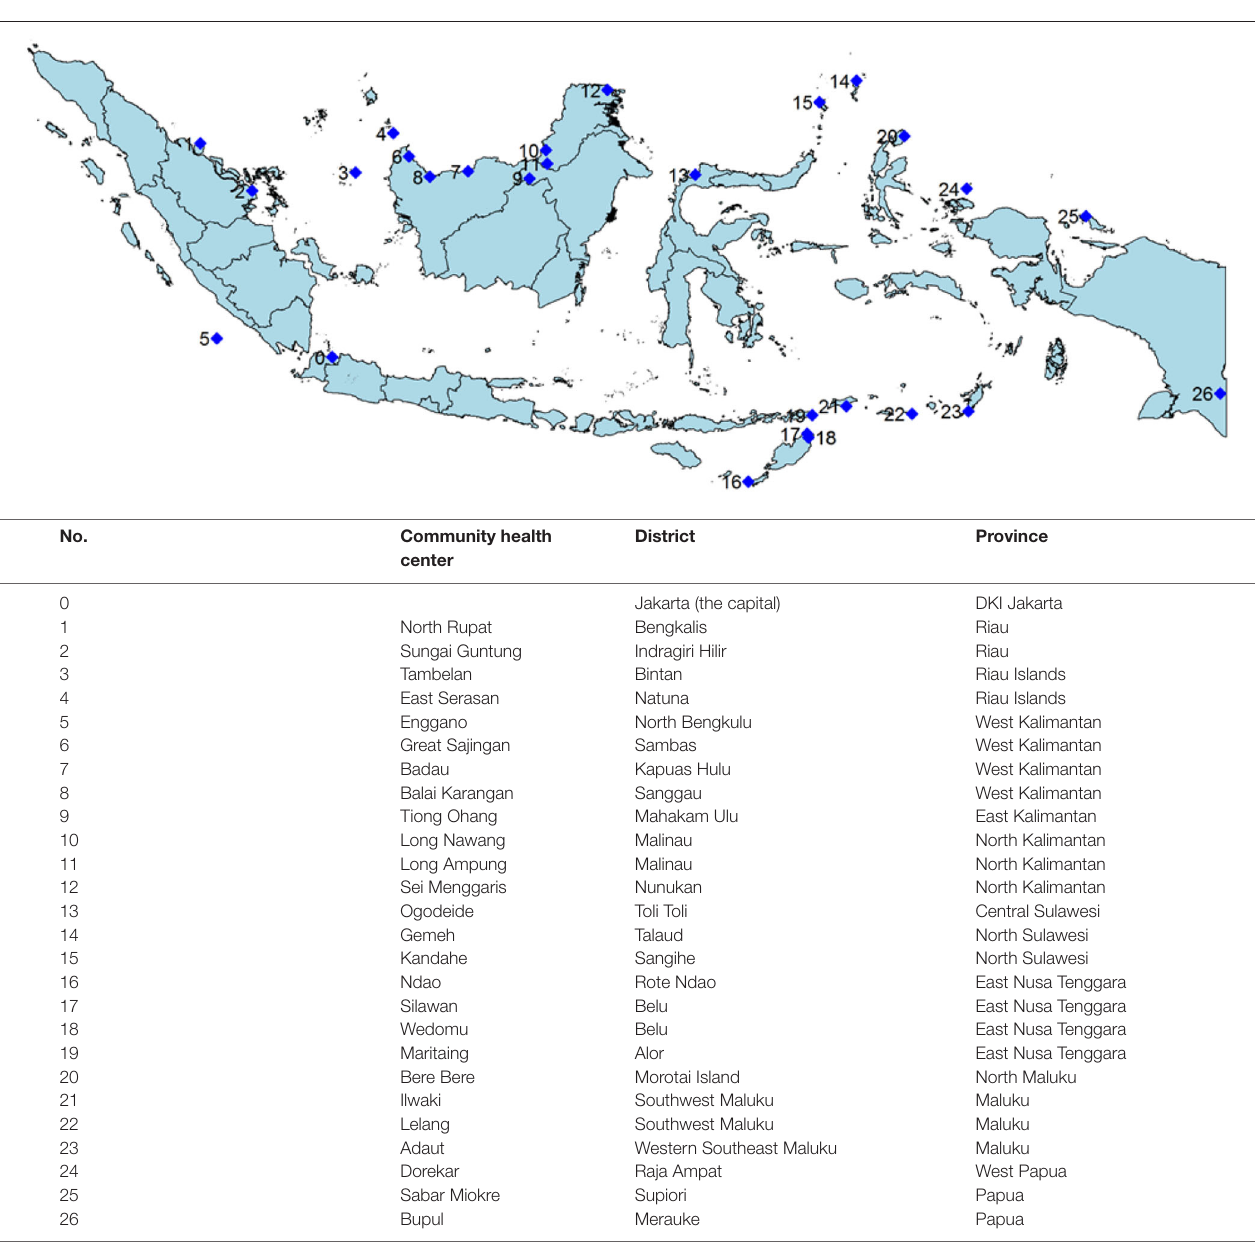
FIGURE 1 | Location of selected community health